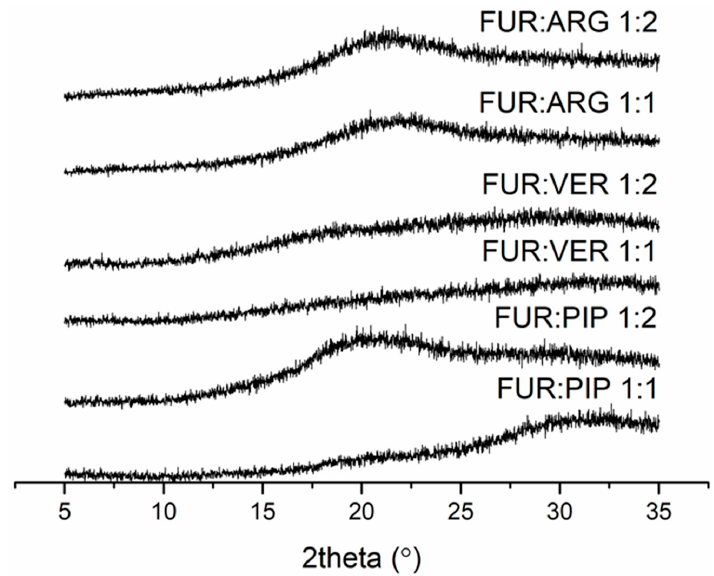
Figure 1. X-ray diffractograms of furosemide (FUR):arginine (ARG) and FUR:D-ARG at 1:1 and 1:2 molar ratios prepared by spray drying, and FUR:piperine (PIP) and FUR:verapamil HCl (VER) mixtures at 1:1 and 1:2 molar ratios prepared by the evaporation method.